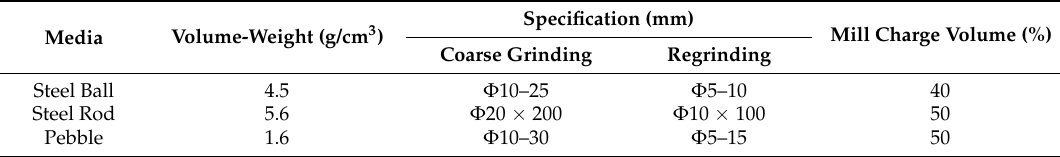
Table 3. Parameters of the grinding